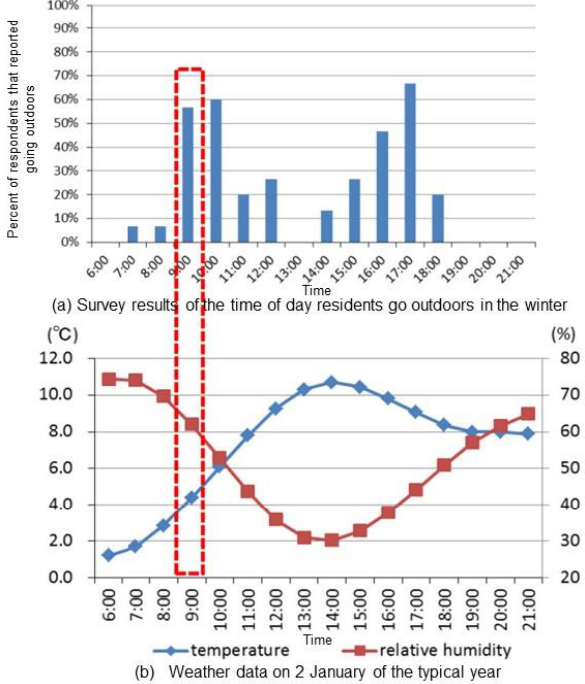
Figure 3. The survey results of the time of day residents go outdoors in the winter ( a ) and weather data on the 2 January of a typical year ( b ).